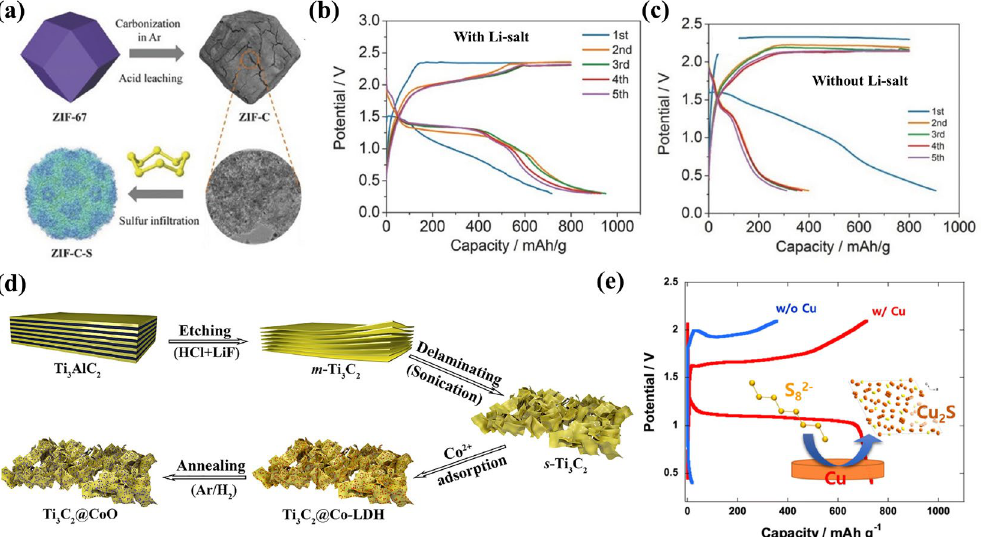
Figure 9. ( a ) S/ZIF − C synthesis method. ( b ) The discharge − charge profiles ( b ) with added LiTFSI and ( c ) without added LiTFSI in Mg(HMDS) 2 − base electrolyte [49] . ( d ) Ti 3 C 2 and Ti 3 C 2 @CoO synthesis methods [58] . ( e ) Comparison of charge − discharge profiles for copper (red) and aluminum (blue) current collectors [63] .